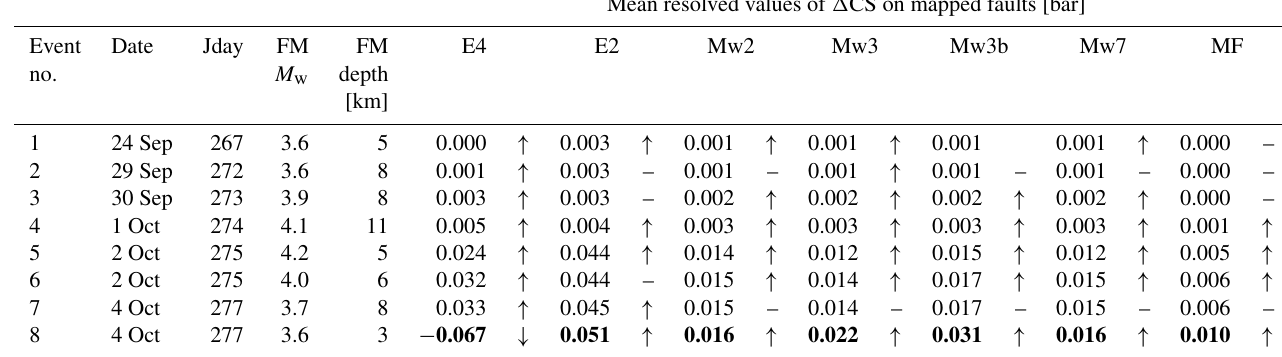
Table D1. Cumulative (cid:49) CS evolution (mean values obtained by taking into account all patches of a particular fault) on each mapped fault. The arrows next to each value indicate whether the fault plane experiences an increase or decrease in Coulomb stress with respect to its previous state, while a dash indicates that there is no variation.